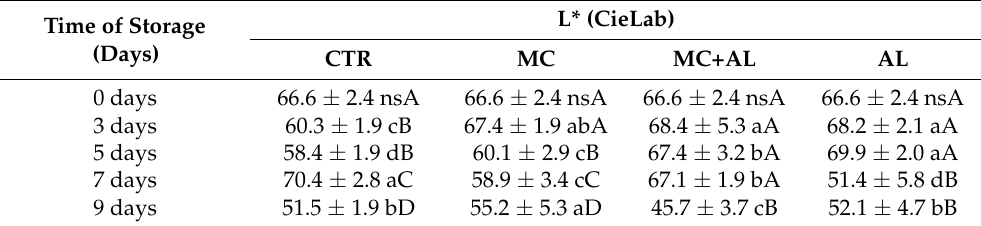
Table 3. Color L* of fruit slices of Actinidia deliciosa (Liang. Ferguson) coated with O. ficus-indica (OFI) mucilage (MC), or mucilage + A. arborescens (MC+AL) or A. arborescens (AL) not treated (CTR), just after being coated (0) and at 3, 5, 7, 9 d of storage at 5 ◦ C. Different lowercase letters indicate significant differences between treatments at each sampling date. Different capital letters indicate significant differences between sampling date for the same treatment. Tukeys’ significant test was applied at p ≤ 0.05. Data are means ± S.E. ( n = 3).